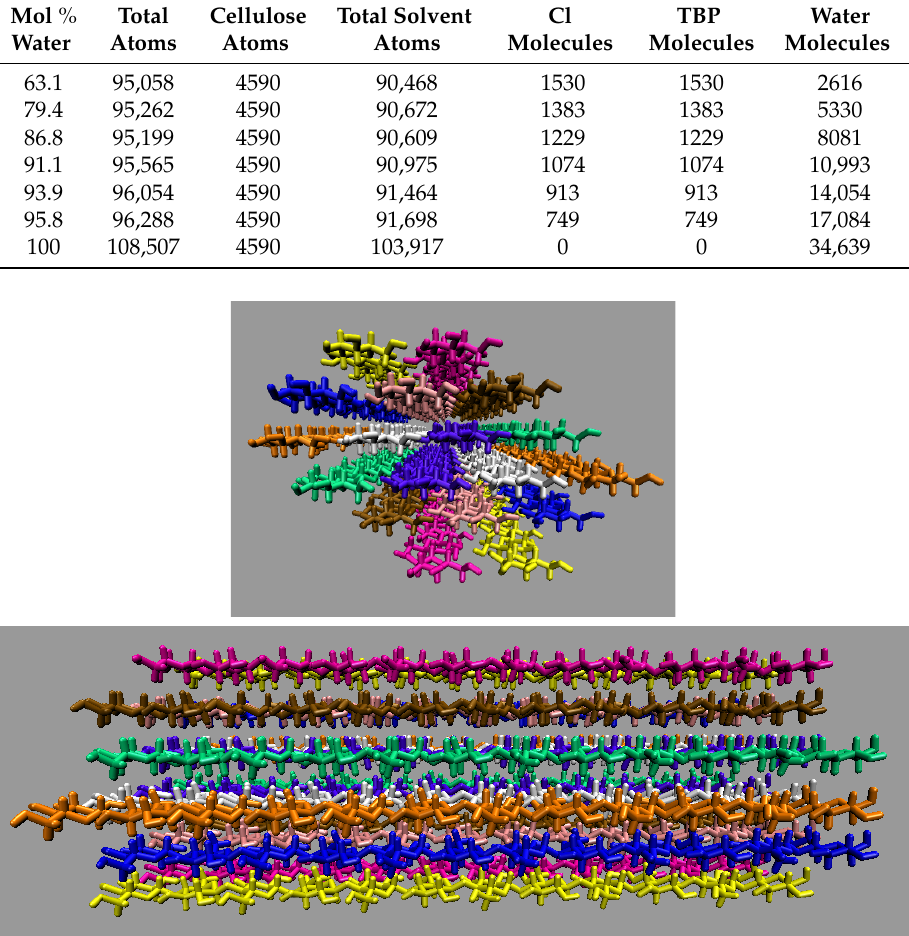
Table 1. Small cellulose bundle (18 strands) simulation compositions.